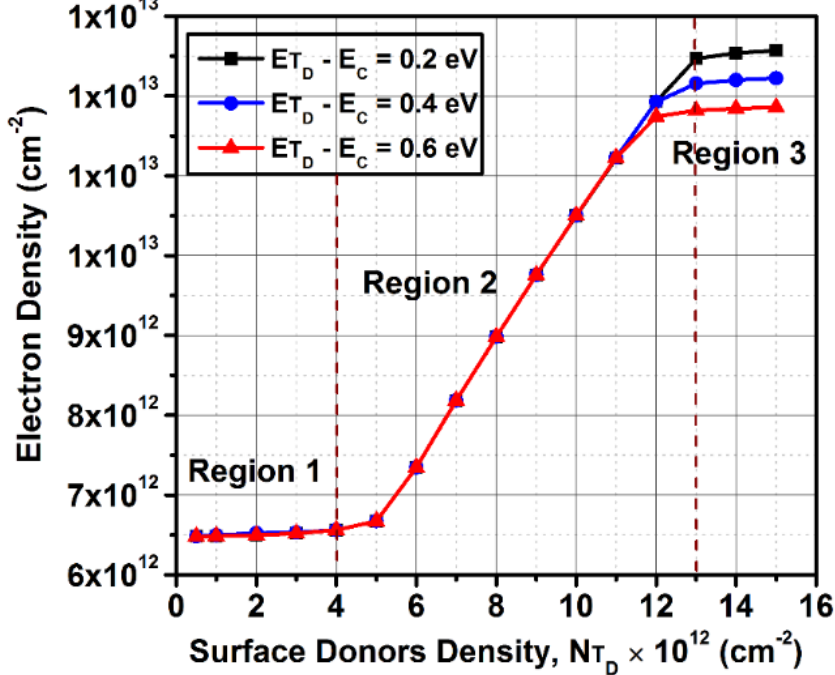
Figure 7. The 2DEG density simulated by varying the surface donor density at different donor energies ( E TD ). Three regions (R1, R2, and R3) are clearly visible in the figure.